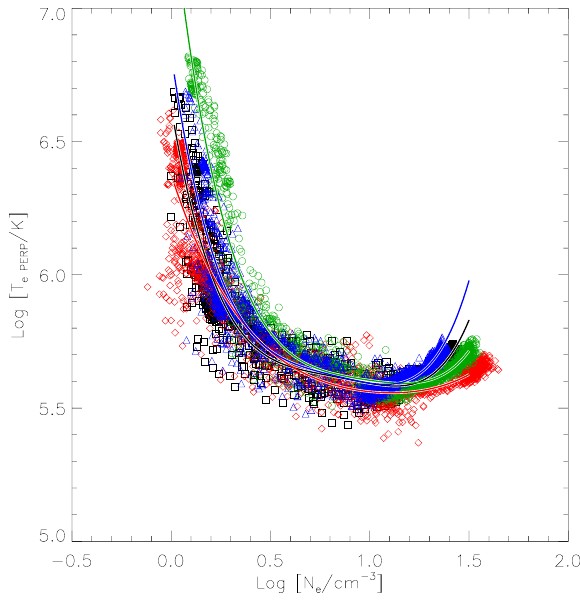
Fig. 3. A scatter plot of the perpendicular electron temperature against the electron density derived from PEACE on-board mo- ments calculated by the HEEA sensor. A fourth order polynomial curve was fitted to the points from each spacecraft (shown). Each data point was projected onto the curve corresponding to the same spacecraft, and the distance along the curve to each projected point was converted to the transition parameter by normalising to extreme